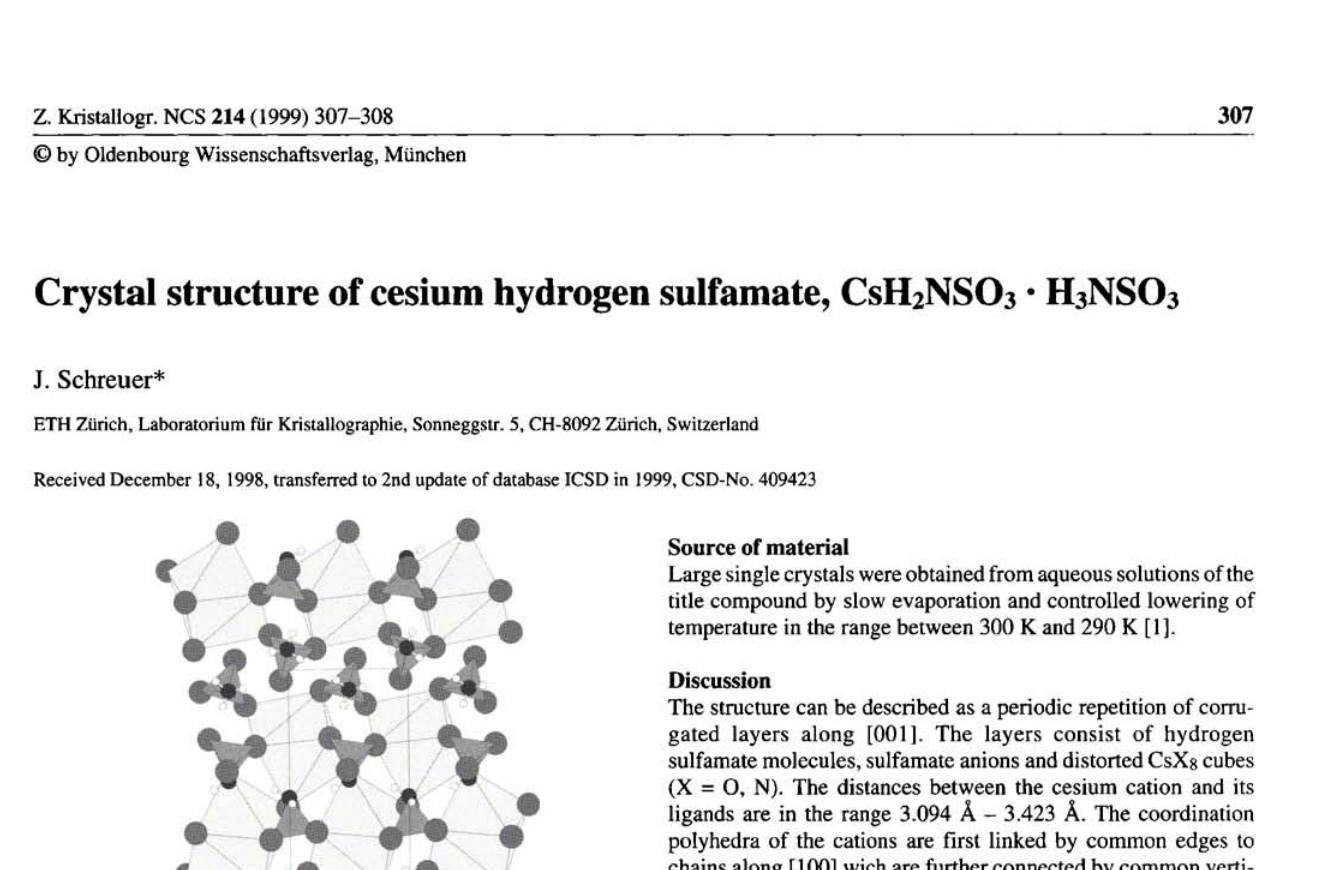
Table 1. Data collection and handling. Crystal: